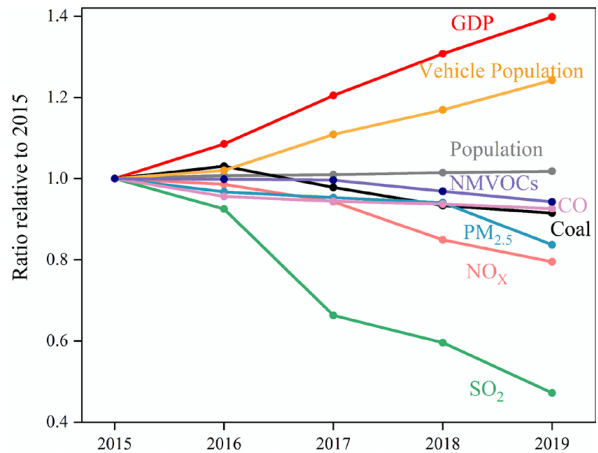
Figure 1. Emission trends and underlying social and economic fac- tors. Coal consumption is obtained from Chinese Energy Statis- tics (National Bureau of Statistics, 2016–2021). The GDP, popula- tion, and vehicle population data come from the National Bureau of Statistics (2016–2021). Data are normalized by dividing the value of each year by their corresponding value in